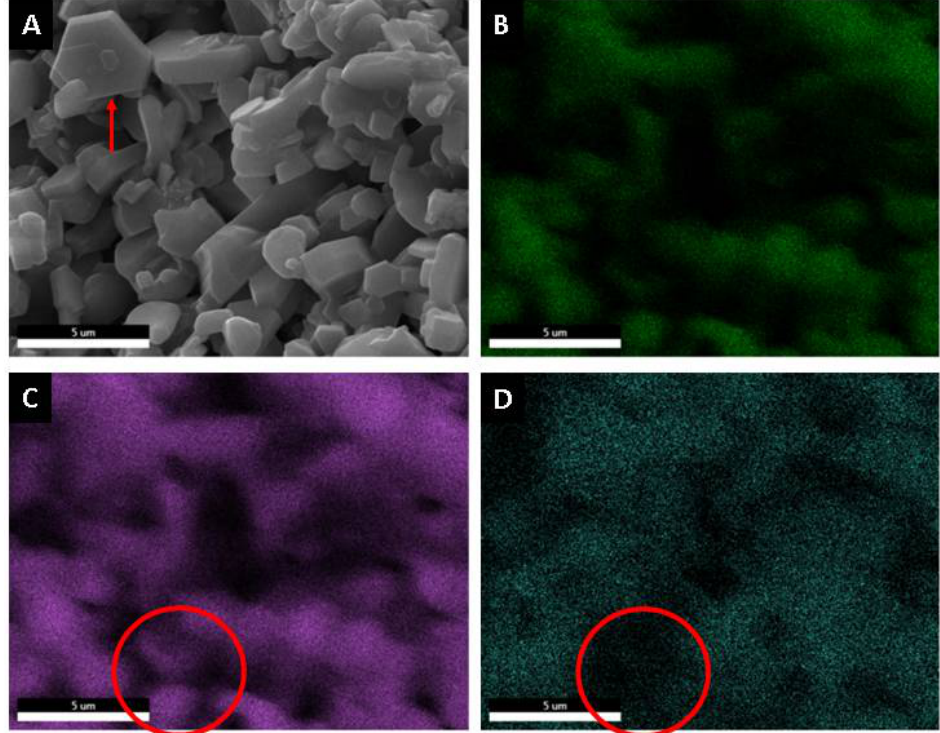
Figure 13. Microelemental mapping analysis surface of alumina spheres treated at 1600 ◦ C. ( A ) Mi- crography, ( B ) Oxygen, ( C ) Aluminum and ( D )